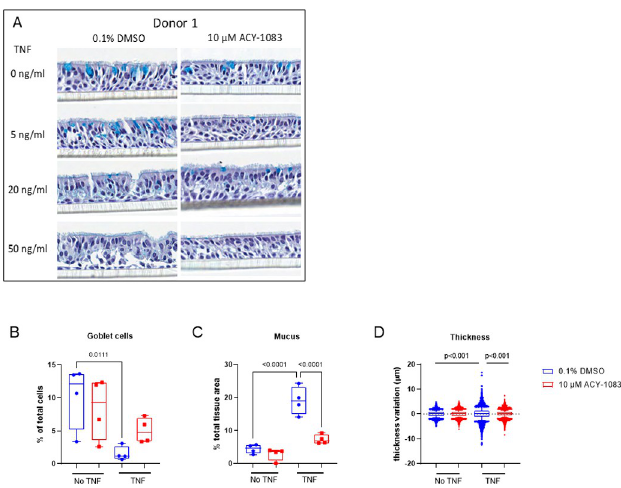
Fig 4. ACY-1083 protects COPD HBEC ALI cultures from TNF-induced damage. (A) AB/PAS staining of sections of ALI cultures show pseudostratified epithelium with goblet cells stained in strong blue. Quantification of (B) goblet cell numbers, (C) intercellular mucus within the epithelium and (D) thickness variation. Box plot with whiskers representing min and max for B and C, 10–90 percentile for D, for each of 4 COPD donors. Statistical analysis was performed using one-way ANOVA with Dunnett´s multiple comparisons